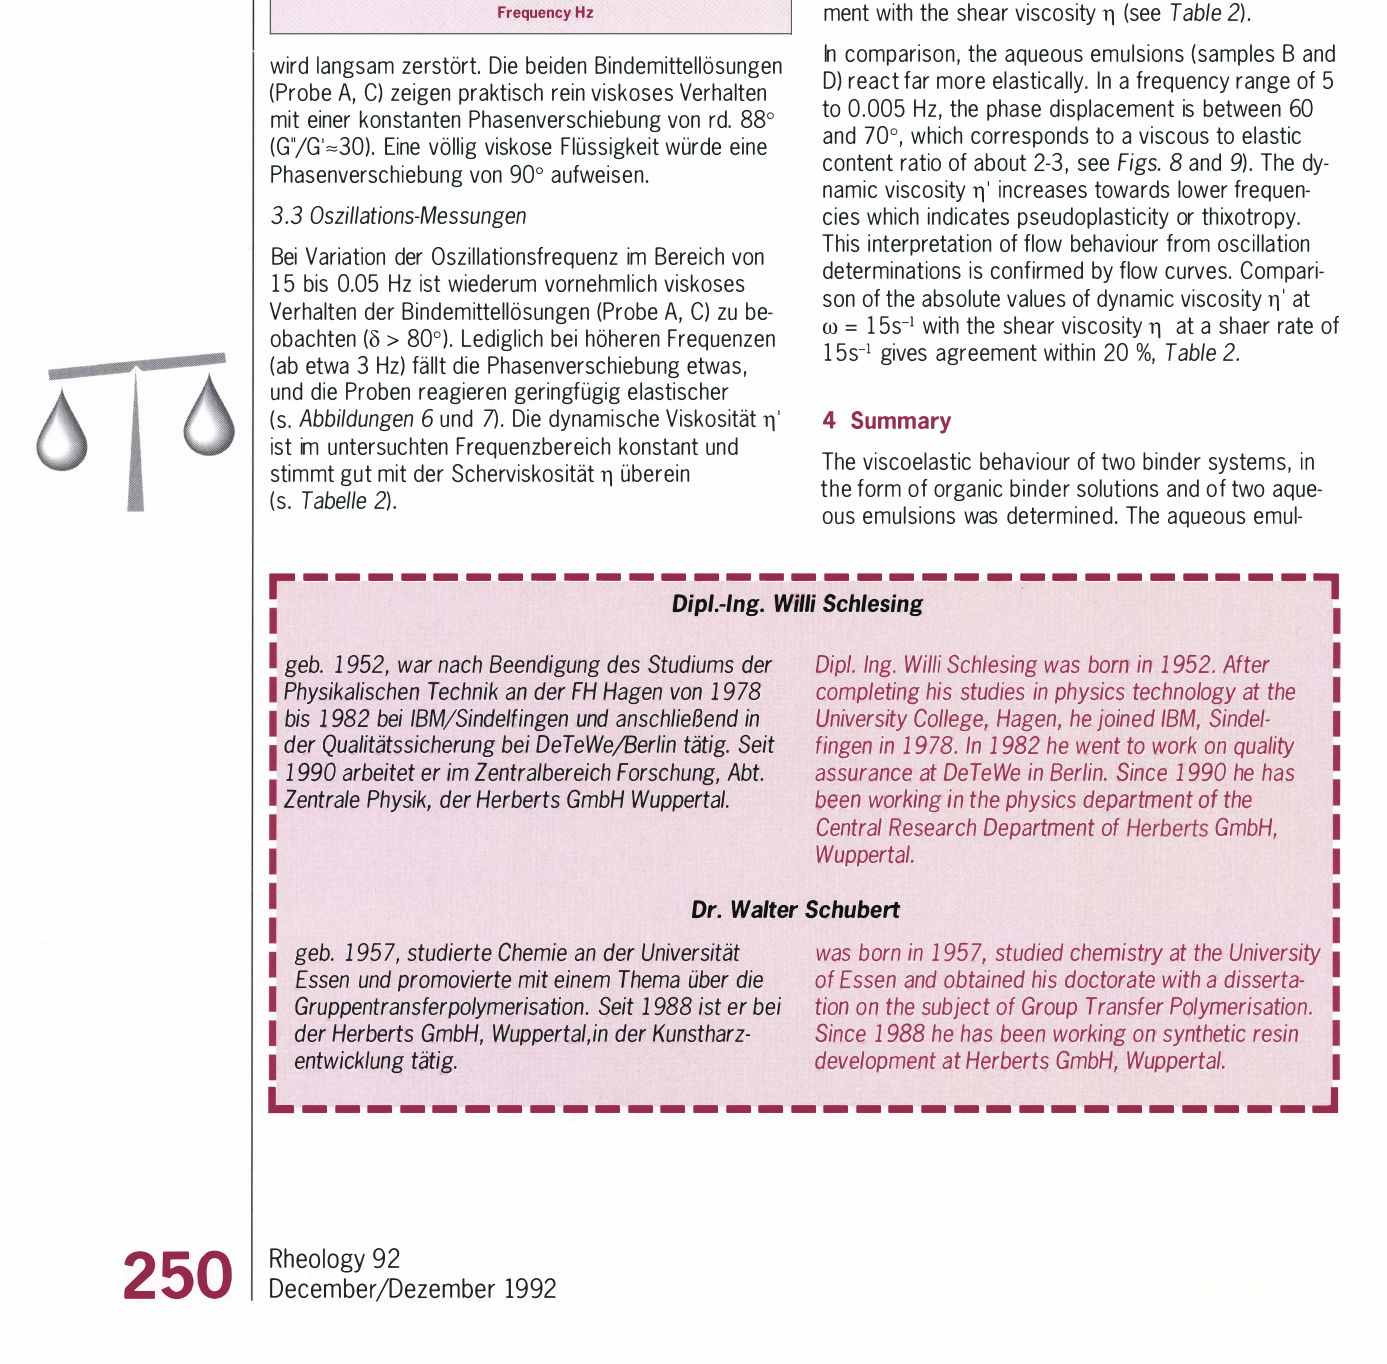
Fig. 9: Oscillation test for emulsion 2 (sample